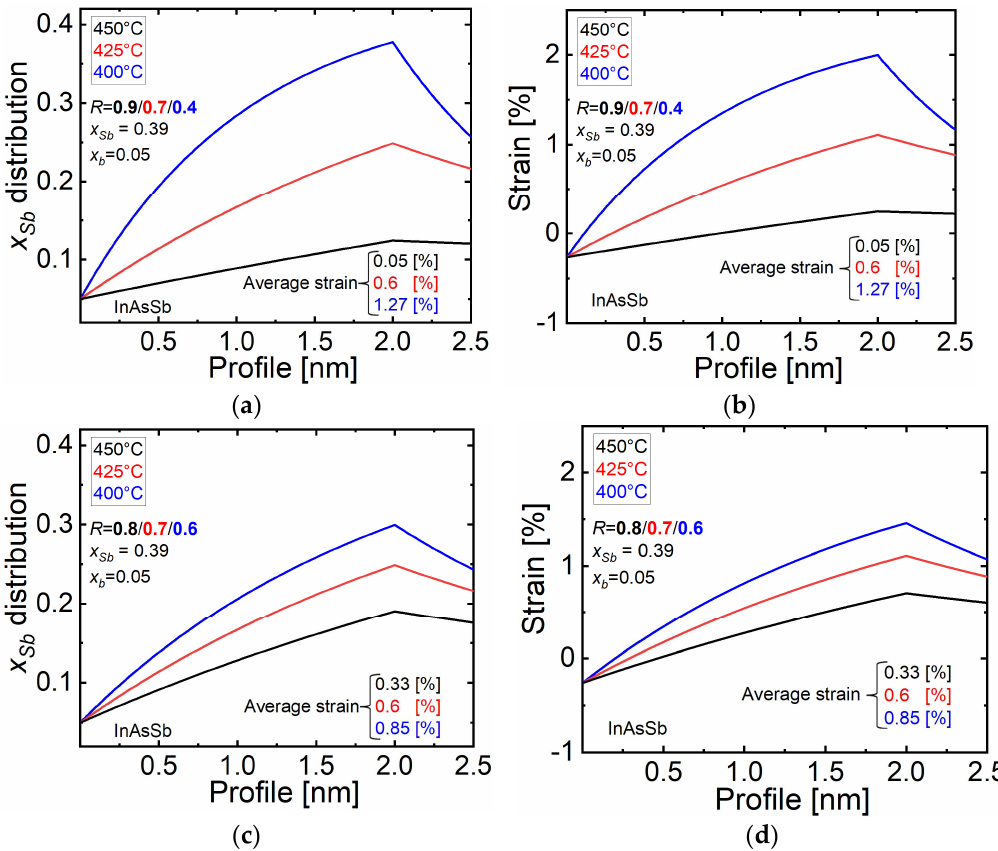
Figure 6. The Sb distribution according to Muraki’s model and 1D in-plane strain (%) distribution in InAsSb in relation to the GaSb for assumed R exchange ranges: ( a , b ) R = 0.9/0.7/0.4 and ( c , d ), R = 0.8/0.7/0.6, corresponding to ( b ) T growth . The measured 100% cut-off wavelengths ( λ 100%cut-off ) for Set I samples 4, 5, and 6 read